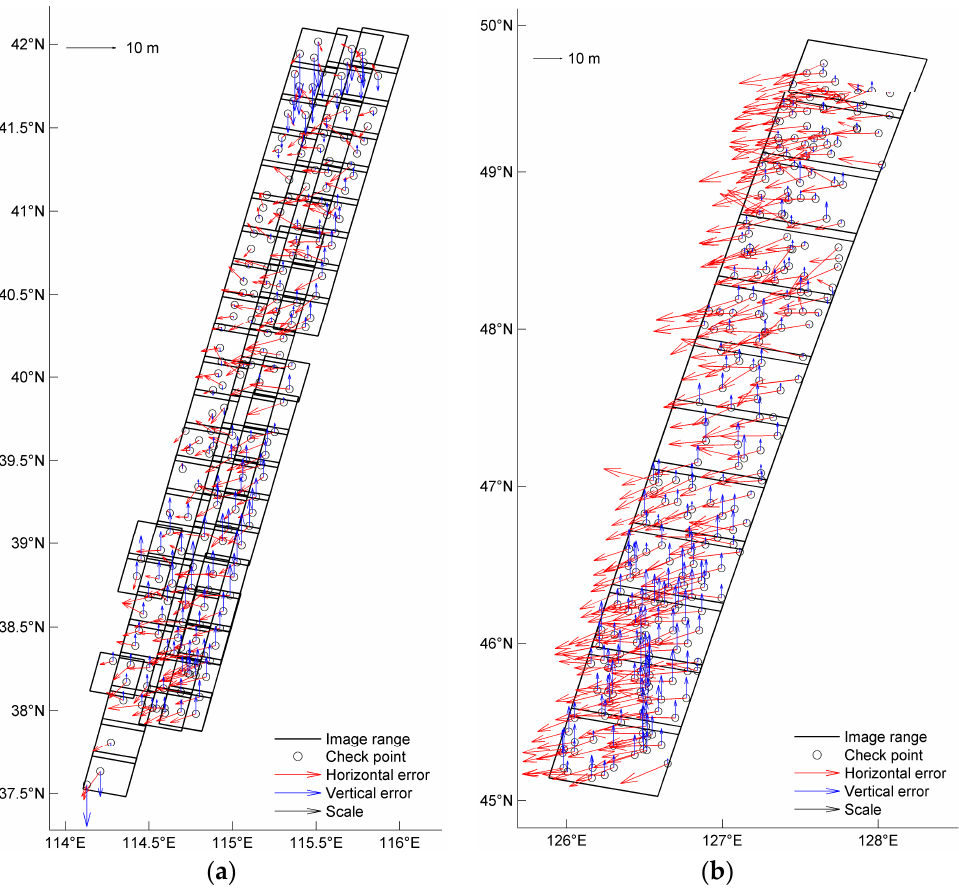
Figure 8. Residuals of the free network adjustment: ( a ) GF7 satellite experimental region, ( b ) ZY3-03 satellite experimental region.